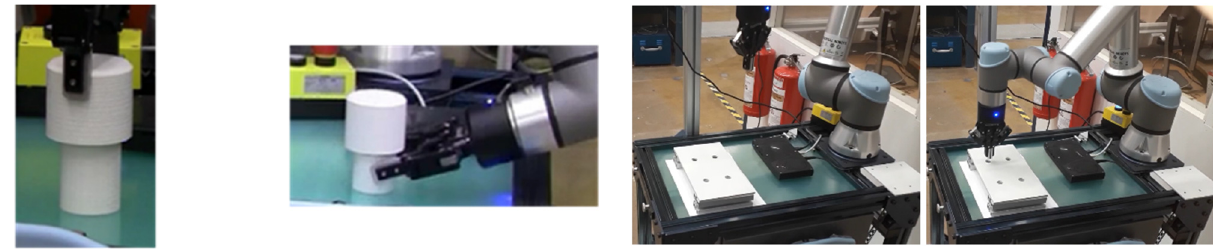
Figure 14: Detection and deburring